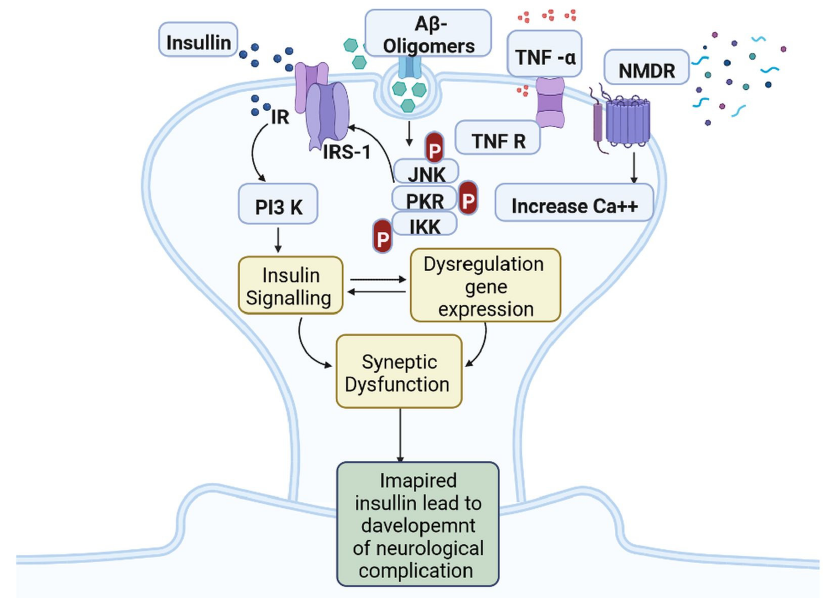
Figure 9. Insulin resistance and development of neuro-complications: the activation of IR autophos- phorylation (IRP) leads to the tyrosine phosphorylation of IRS-1 (insulin receptor substrate 1), which activates PI3K (phosphoinositide 3-kinase) and decreases synaptic plasticity and memory.